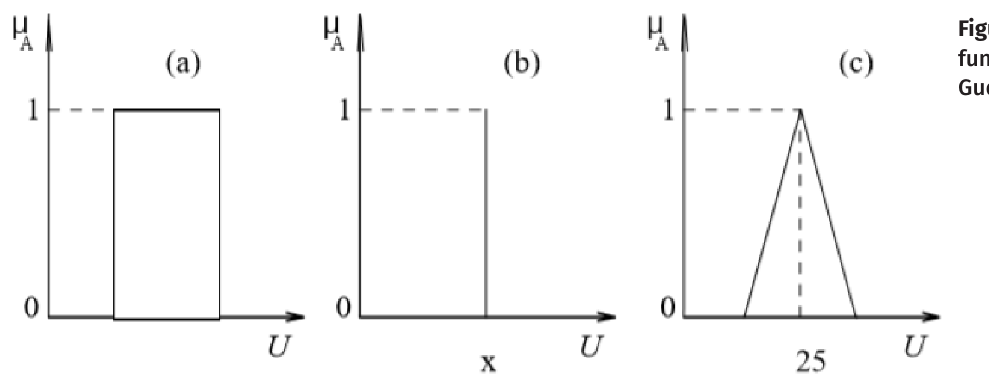
Figure 2. Pertinence functions (Gomide & Gudwin